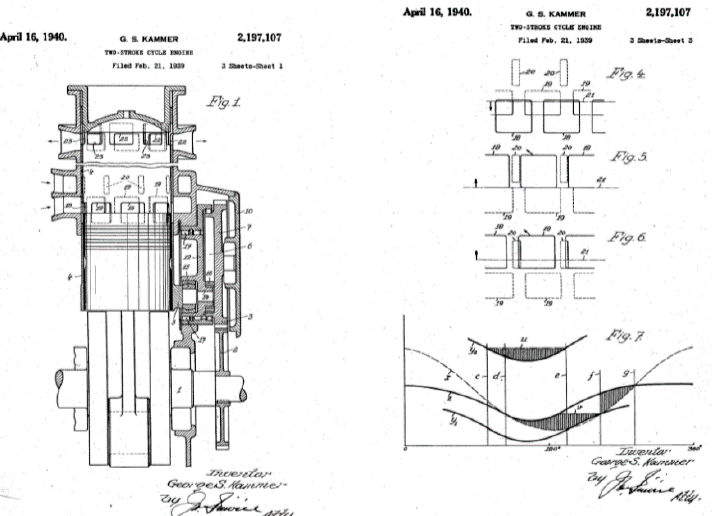
Figure 9. G.S Kammer 21 February 1939, two-stroke cycle US 2197107. Reproduced with permis-